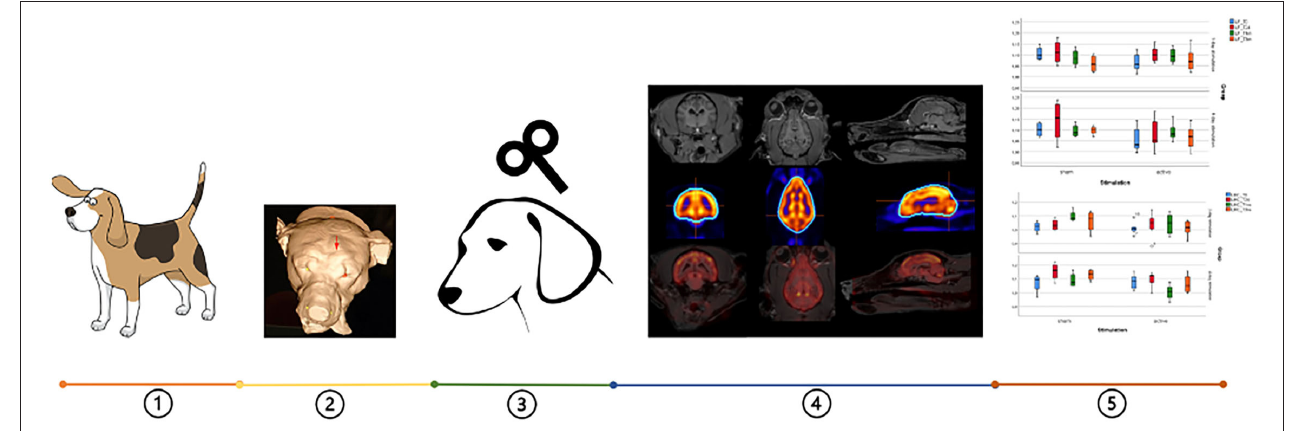
FIGURE 1 | Pipeline of the whole experimental protocol: (1) twelve beagles were used, (2) neuronavigation was conducted to locate the accurate TMS point (red arrow), (3) four types of aHF-rTMS protocols were applied, (4) Images with different regions on the transversal, sagittal and dorsal slices: MRI, [ 18 F]-FDG PET and the fusion of both images, (5) data analysis. TABLE 1 | Statistical results of the different aHF-aTMS protocols. AHF-rTMS